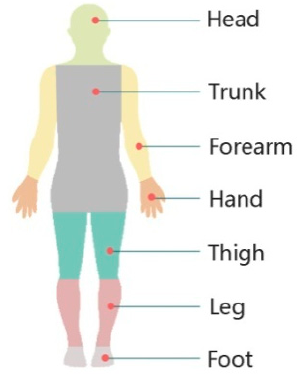
Figure 2. Skin temperature measurement locations.